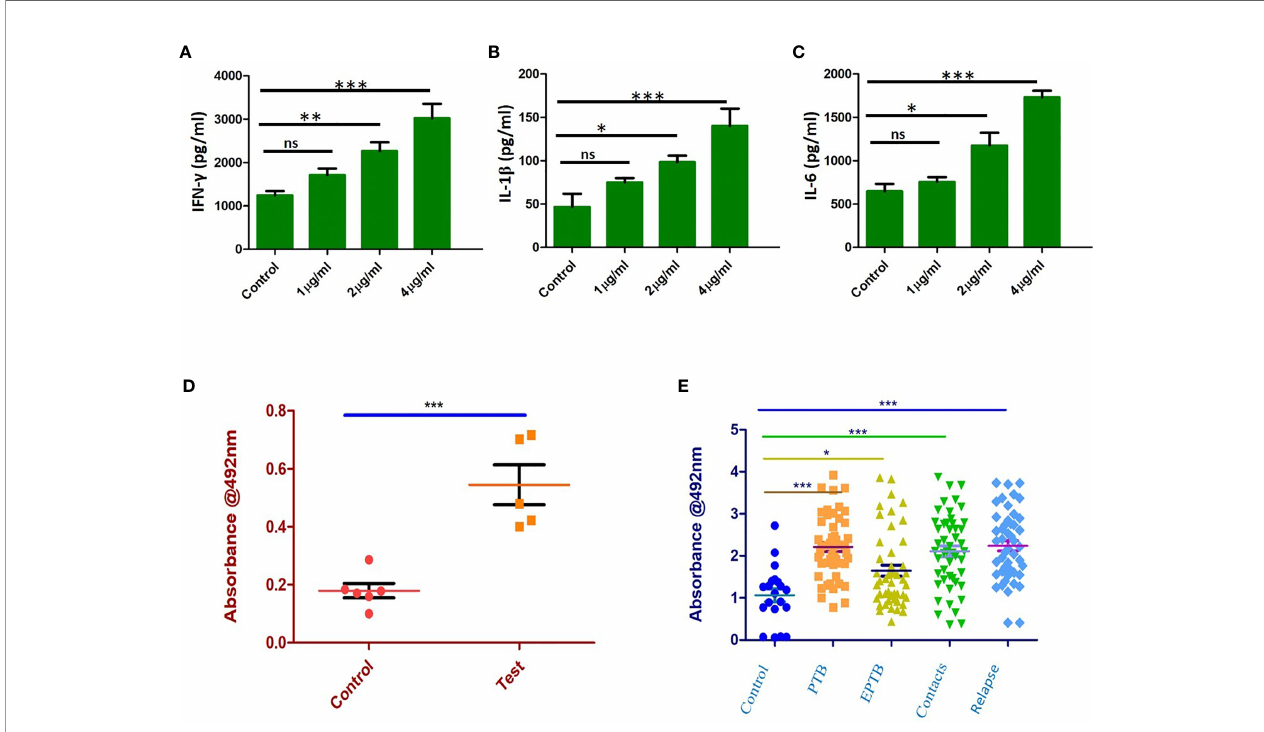
FIGURE 7 | Rv1509 enhances secretion of Th1 cytokines in re-stimulated splenocytes and elicits strong B cell response in human TB patients. (A) Splenocytes were re-stimulated with Rv1509 in culture for 72 hrs. Supernatant from the culture was collected for sandwich ELISA. Signi fi cant increase in the level of IFN g as a direct function of protein concentration could be seen along with IL1 b (B) and IL-6 (C) . (D) B-cell response against Rv1509 shows a signi fi cant response in immunized mice. Serum from immunized and control animals was added to ELISA plate coated with 10 µg/ml of recombinant Rv1509. After incubation, plates were washed and bound total IgG was detected by enzyme labelled secondary anti-mouse IgG. O.D (Optical Density) is plotted as dot plots with each dot representing an animal. The data presented are from fi ve animals in each group from a representative experiment. The increase in OD is statistically signi fi cant in case of immunized animals as compared to controls (p < 0.001). (E) Immunoreactivity of sera from different categories of TB patients with Rv1509 protein was studied using ELISA. Statistically signi fi cant immunoglobin IgG response was elicited by Rv1509 against control (n = 20), PTB (n = 40), EPTB (n=40), contacts (n = 40) and relapse (n = 40) cases of tuberculosis. *p < 0.05, **p < 0.01 and ***p < 0.001. ns, non-signi fi cance. (The data are expressed as mean ±